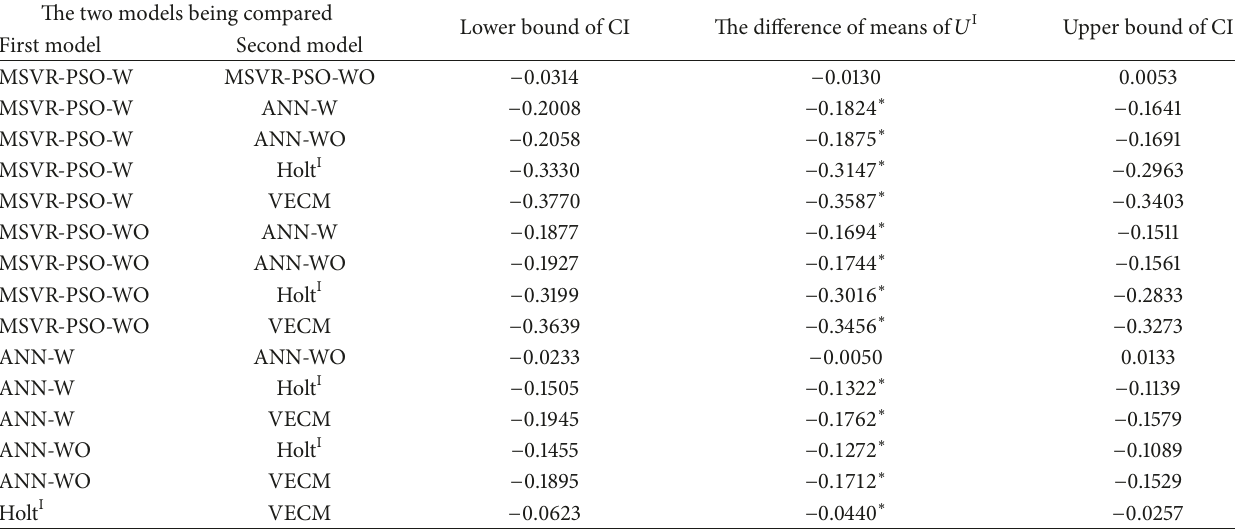
Table 6: Multiple comparison test